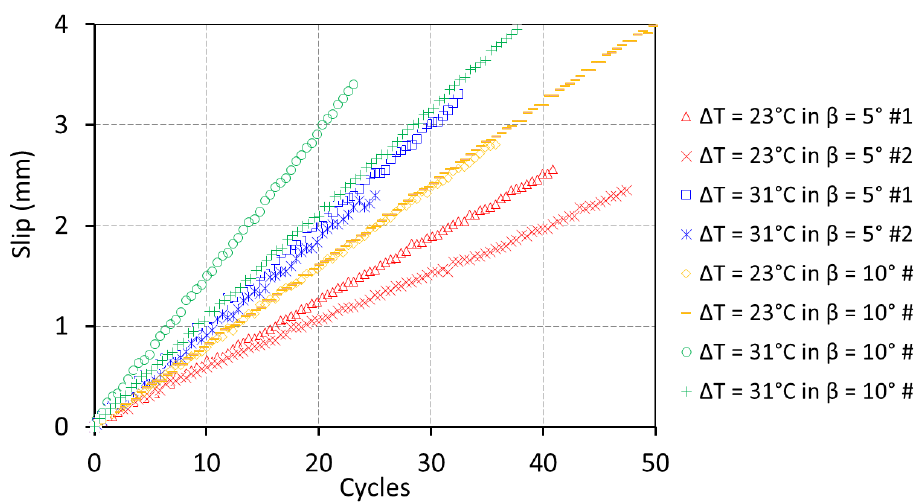
Figure 2. Slip growth with the number of temperature cycles from the experimental study. Four different cases ( 5 V and 6 V of power supply with 5° and 10° of the inclination angles) are presented with two separate implementations for each different cases (5 V and 6 V of power supply with 5 ◦ and 10 ◦ of the inclination angles) are presented case. with two separate implementations for each